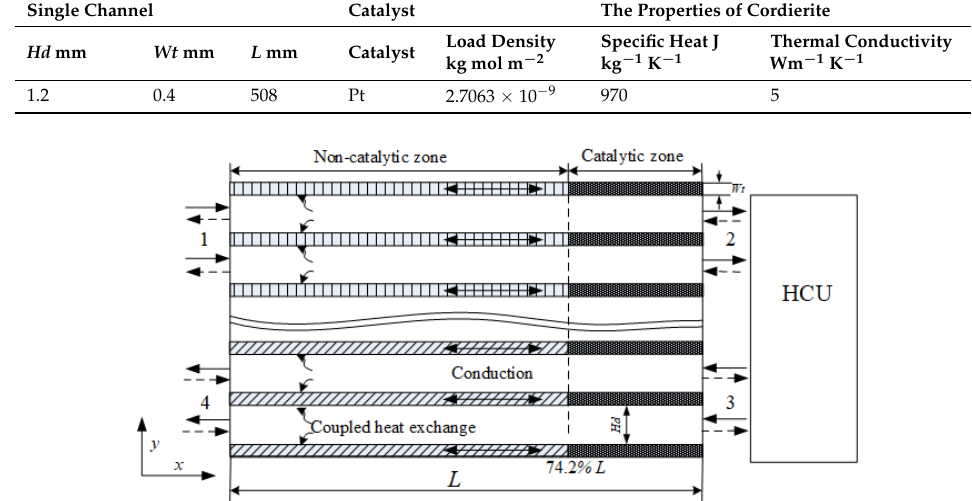
Table 1. Parameters of a reactor channel.